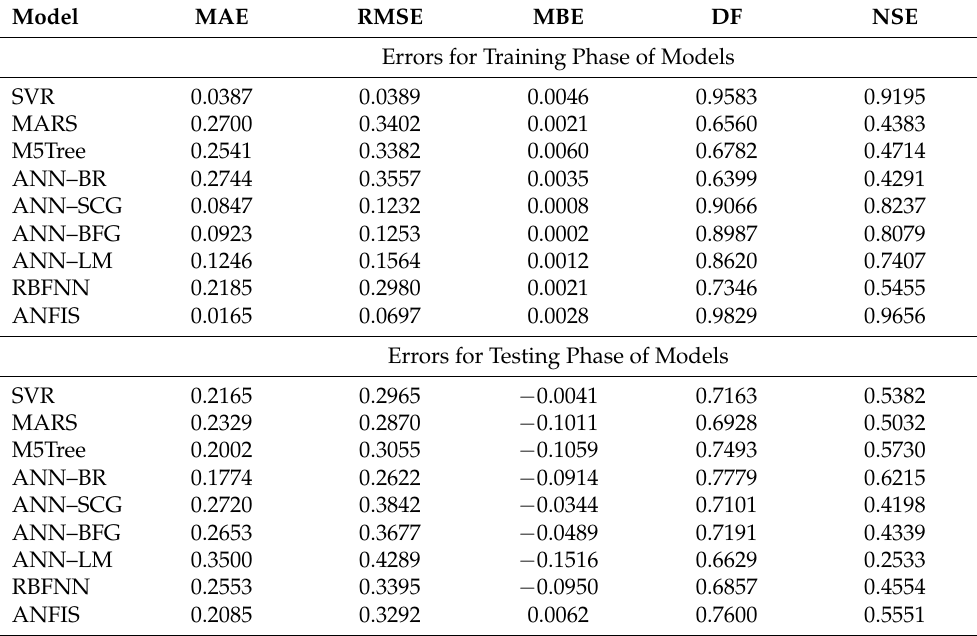
Table 5. The comparative results of the indicated model for training and testing phases; see abbrevia- tions in Nomenclature.